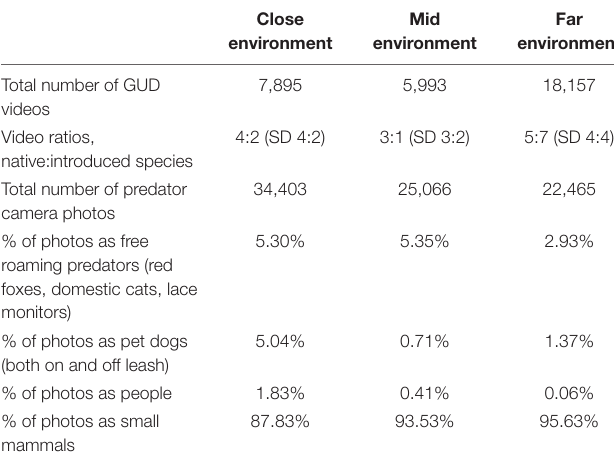
TABLE 3 | The summary of the total number of GUD videos and baited predator camera photos obtained using infra-red motion-sensor cameras at three locations (“close environment,” “mid environment,” and “far environment”) along an urban disturbance gradient for three nights of pre-treatment conditions and three nights of treatment conditions replicated across four survey sessions in 1 year ( n = 288 per GUD trial).